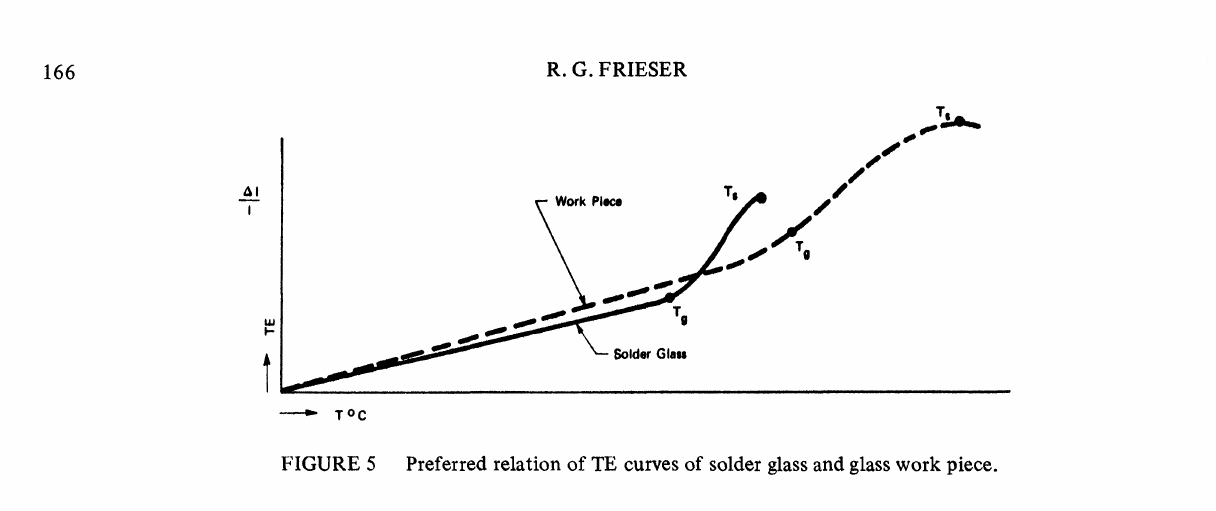
FIGURE 5 Preferred relation of TE curves of solder glass and glass work piece.